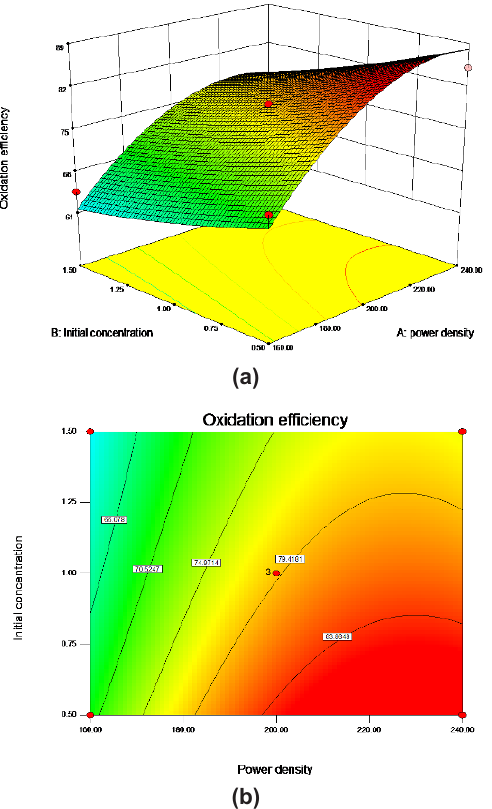
Figure 6. Effect of power density and initial concentration of arsenite on the arsenite oxidation efficiency with the H concentration at the zero level: (a) response surface and (b) contour plot of the predicted oxidation efficiency.